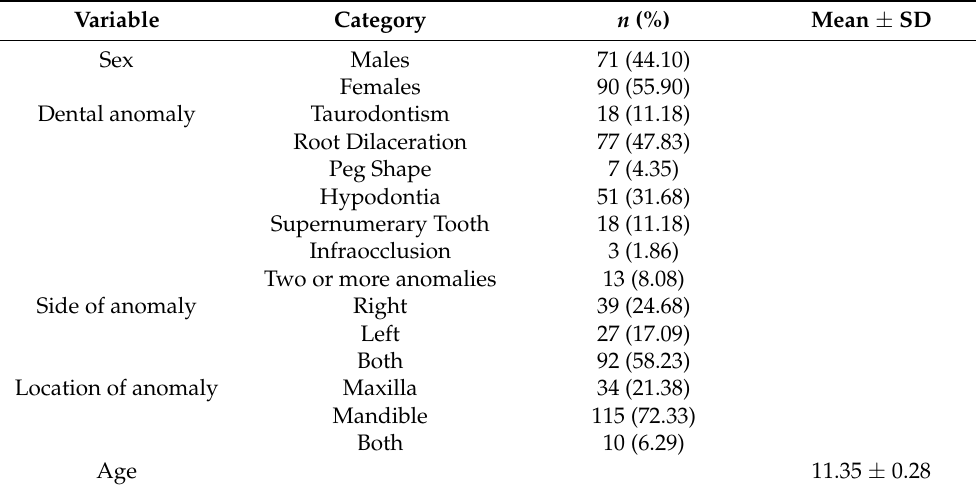
Table 1. Descriptive statistics of demographic data and dental anomalies ( n = 161).